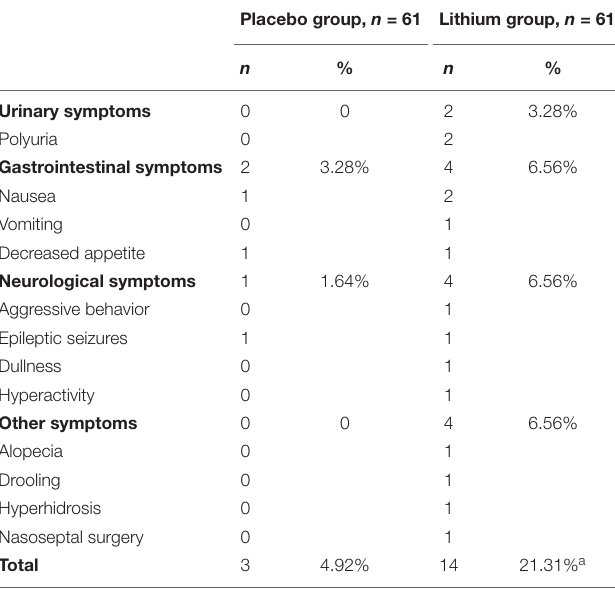
TABLE 2 | Adverse events during the treatment period. Placebo group, n = 61 Lithium group, n =